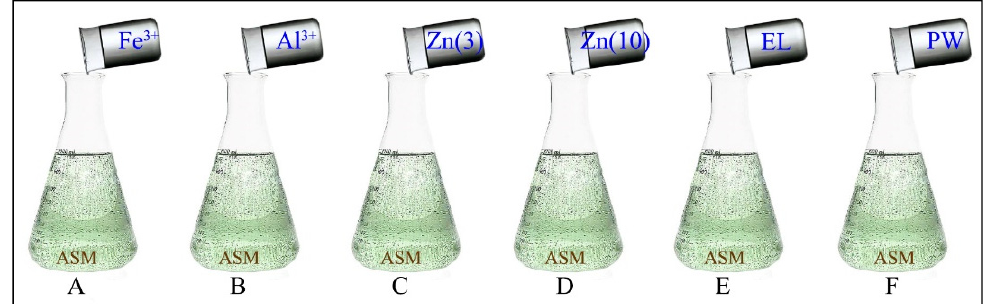
Figure 1. Schematic diagram of the six treatments. The samples were randomly divided into groups A, B, C, D, E, and F (light green). An American Society for Microbiology medium (ASM) was added to the A, B, C, D, E, and F treatments, along with Fe 3+ , Al 3+ , 3 mol/L zinc Zn (3), 10 mol/L zinc Zn (10), Eucalyptus leaves (EL), and pure water, respectively.